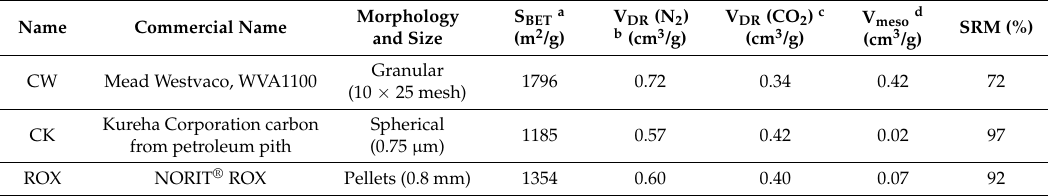
Table 4. Textural properties and SRM values of some commercial activated carbons.